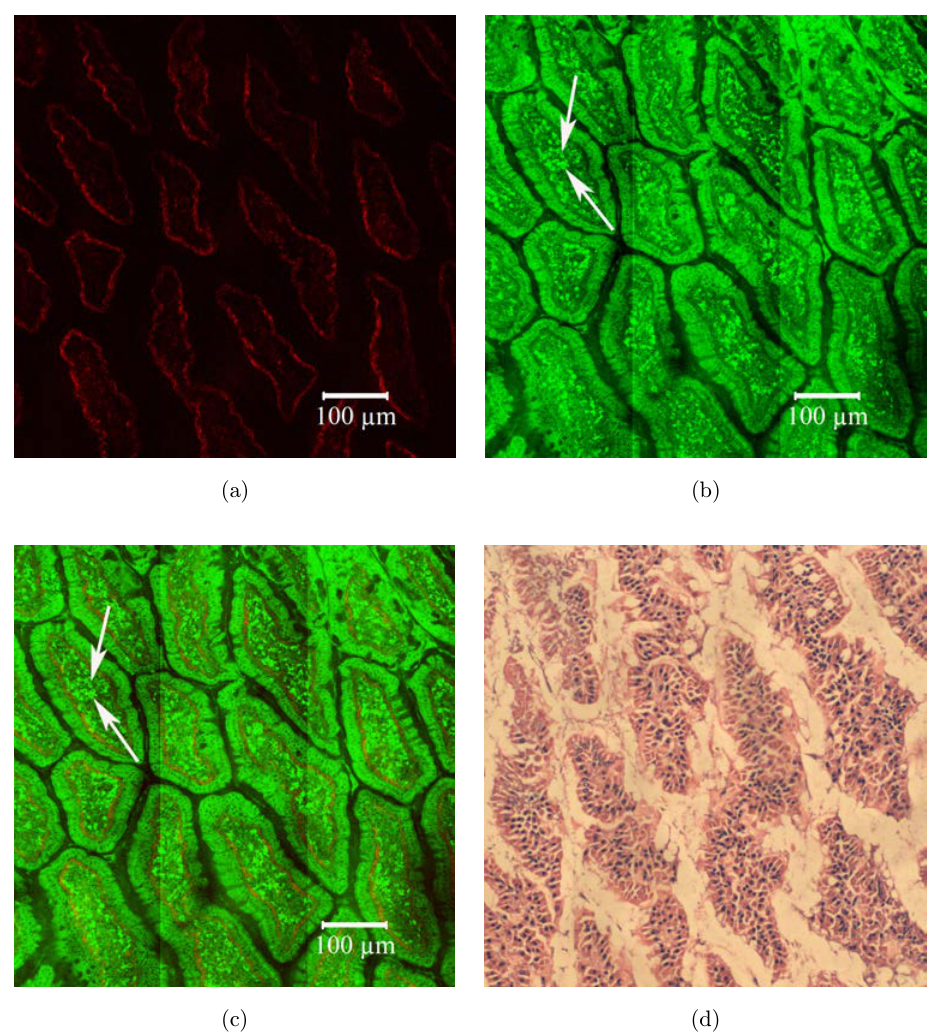
Fig. 1. Images of duodenal mucosa. (a) SHG image of collagen, (b) TPEF image of cells, (c) overlayed SHG/TPEF image, and (d) the corresponding H&E image (20 (cid:2) ) showing a similar arrangement compared to the overlayed SHG/TPEF image. Scale bar is 100 (cid:1) m. The white arrows indicate the lymphocytes or plasma